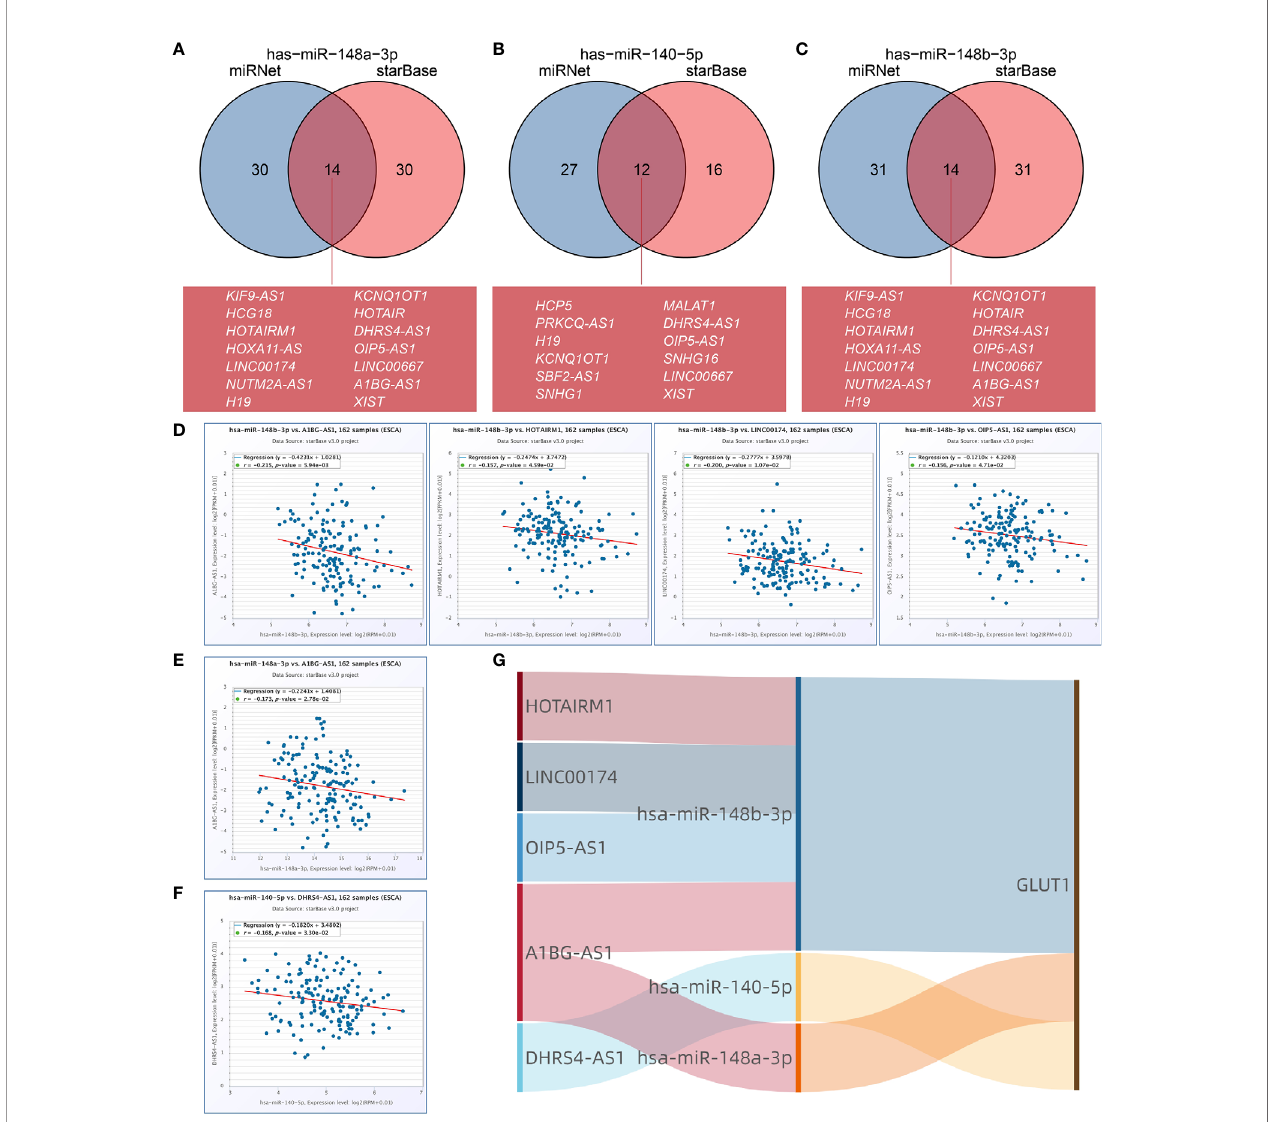
FIGURE 6 | Prediction of lncRNA and ceRNA network construction in esophageal carcinoma (ESCA). The Venn diagram respectively shows the target lncRNA of has-miR-148a-3p (A) , has-miR-140-5p (B) , and has-miR-148b-3p (C) . Use starBase software to analyze the correlation between miRNA and the target lncRNA. Use scatter plots to show miRNA-mRNA with signi fi cant correlation. LncRNA related to has-miR-148b-3p (D) . LncRNA related to has-miR- 148a-3p (E) . LncRNA related to has-miR-140-5p (F) . (G) The Sankey diagram shows the lncRNA-miRNA-mRNA (GLUT1) regulatory network in line with the ceRNA